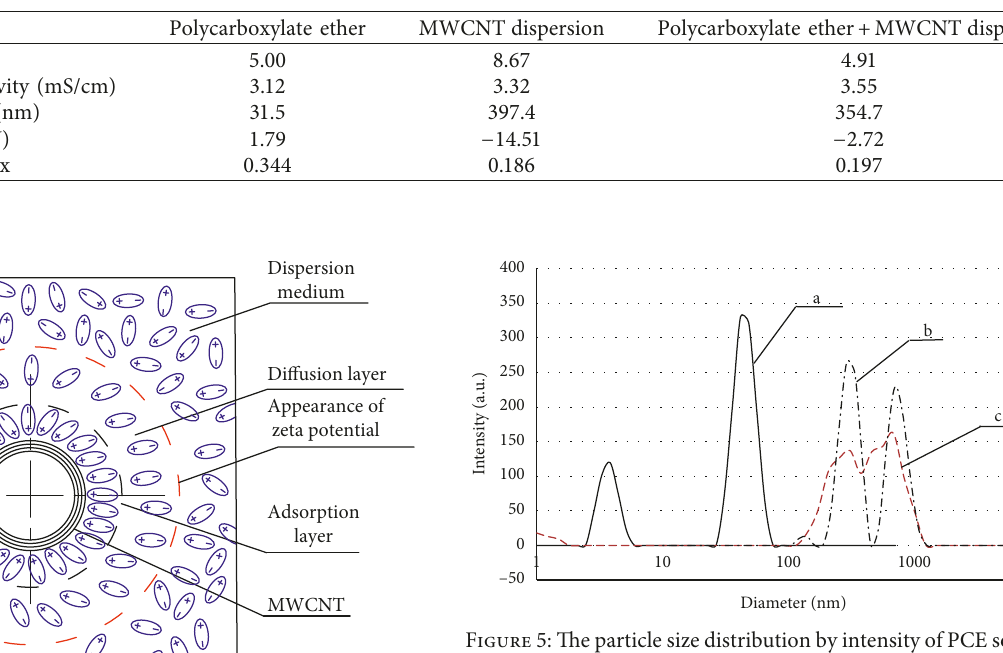
Table 4: Characteristics of the samples.